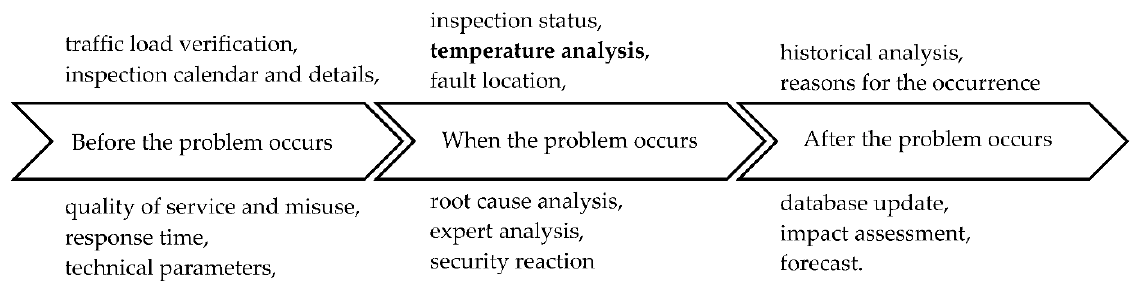
Figure 17. Data collection during the life cycle of the EOR heater (source: authors).